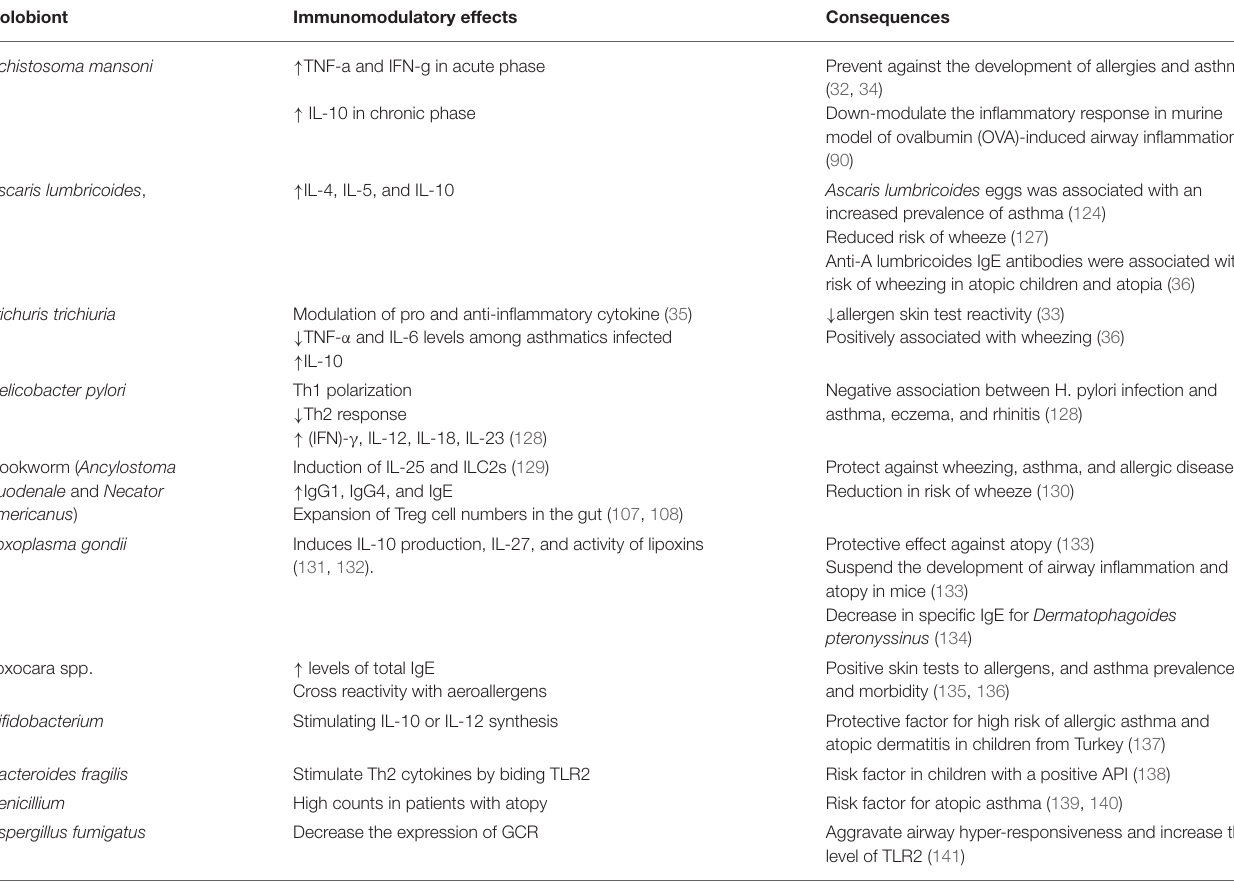
TABLE 2 | Summary of the immunomodulatory effects of some halobiont’s organisms on asthma and allergy.